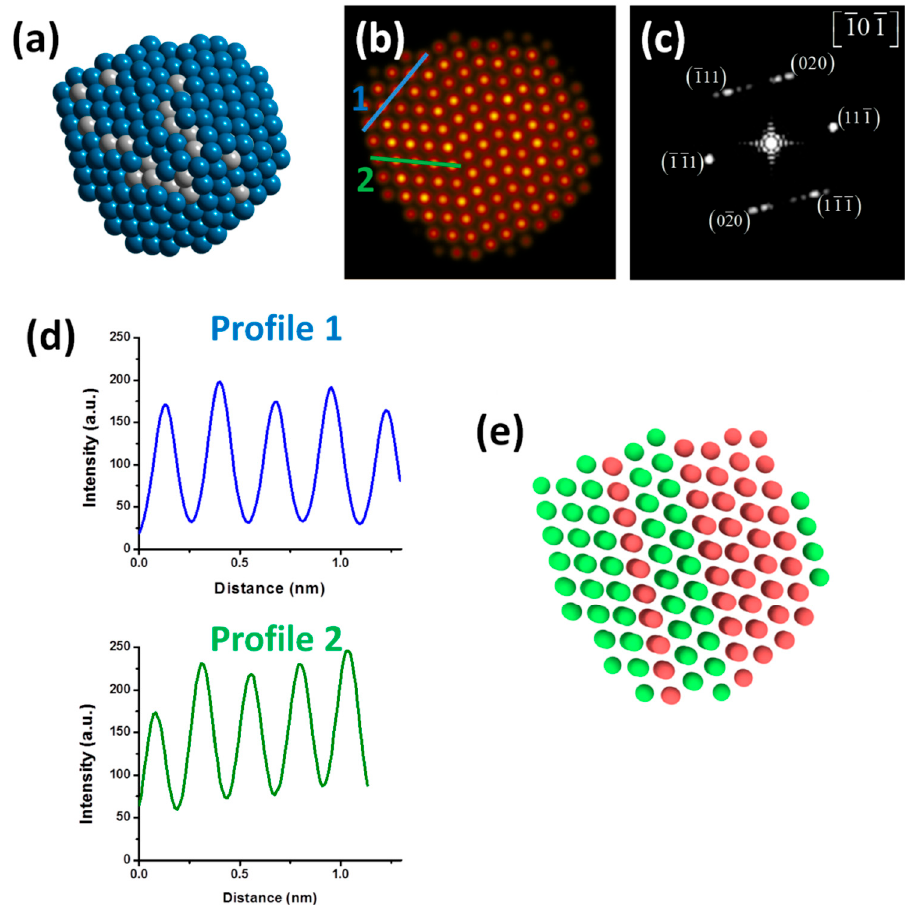
Figure 7. ( a ) Model of the PdPt (1:1) nanoparticle after the cooling process (Pd = blue and Pt = grey), ( b ) Simulated high-angle annular dark-field scanning transmission electron microscopy (HAADF-STEM) image of the PdPt (1:1) nanoparticle, ( c ) Fast Fourier transform (FFT) of the simulated HAADF-STEM image, ( d ) intensity profiles along two directions and ( e ) Atoms colored according to their crystal stacking structure calculated using a common neighbor analysis (green = FCC and red = HCP).